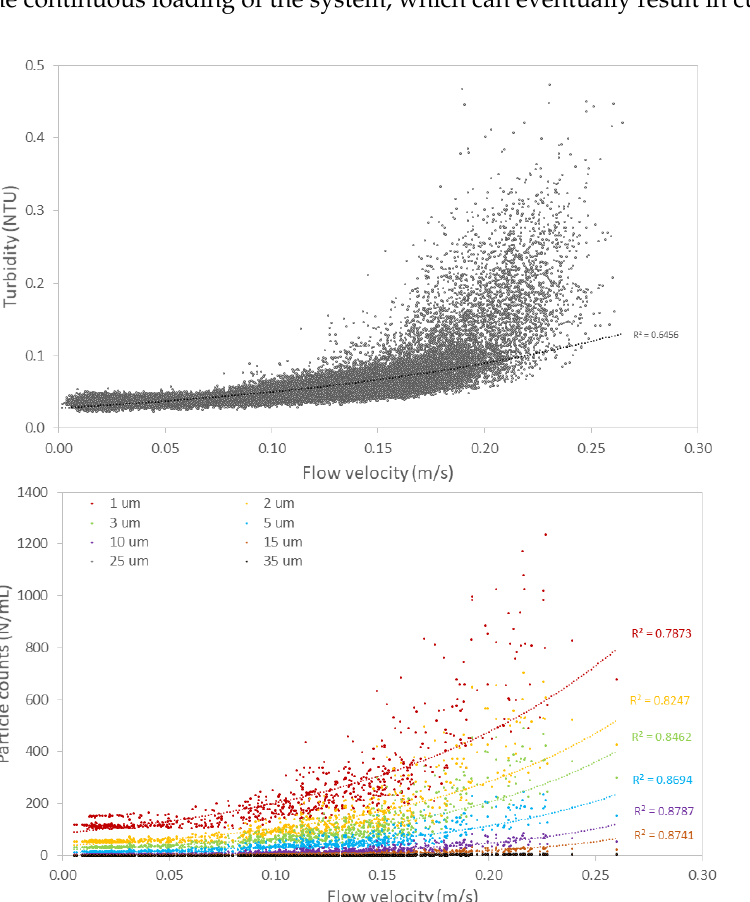
Figure 6. Relation between flow velocity and turbidity ( top figure ) and counts of particles of different sizes ( bottom figure ) at distribution location E based on measurements collected during one week.